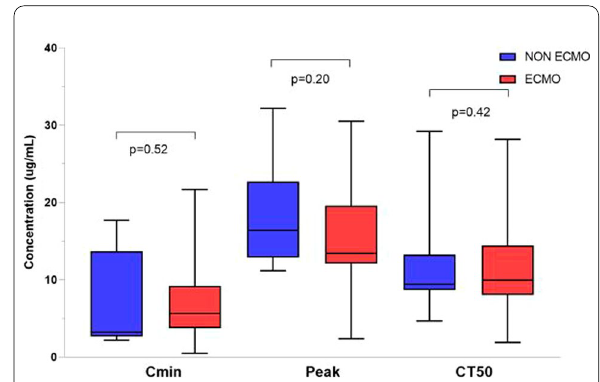
Fig. 1 Ceftobiprole serum measurements for 35 patients, 7 in the non- ECMO group and 28 in the ECMO group. The data distribution was depicted with the use of boxplots expressing median, interquartile range and extreme values